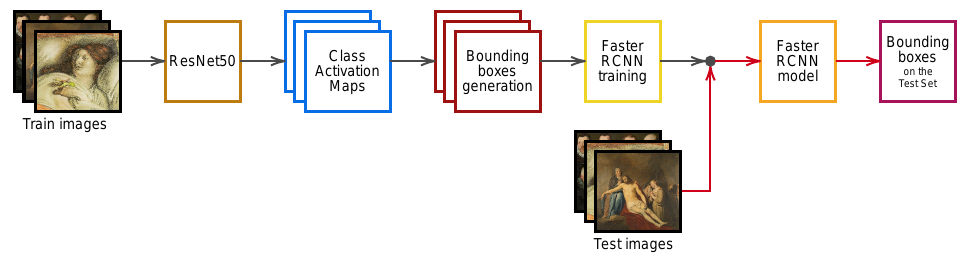
Figure 1. Proposed pipeline —The pipeline comprises several steps: (1) training of a ResNet-50 classifier on train set images; (2) computation of Class Activation Maps; (3) devising of bounding boxes surrounding the connected components on train set images; (4) use of the obtained bounding boxes as pseudo-GT to train a Faster R-CNN object detector; and (5) application of the trained detector model on test images. Gray arrows indicate the training steps, while red arrows indicate the testing